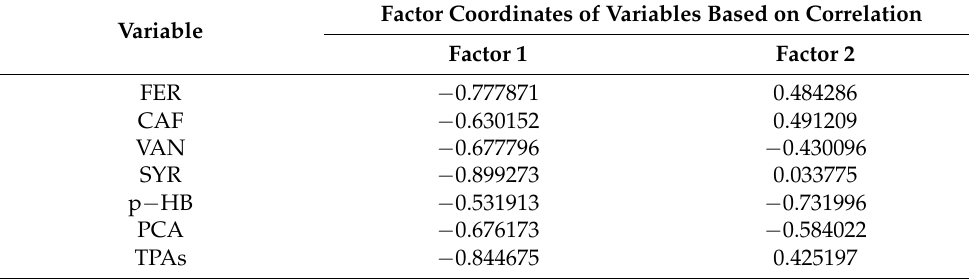
Table 8. Value of principal components coefficients. Factor Coordinates of Variables Based on Variable